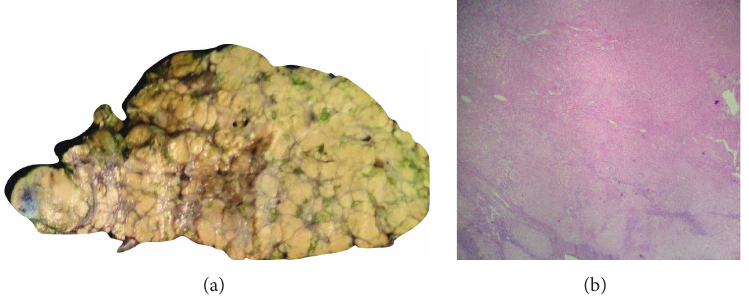
Figure 2: (a) Macroregenerative nodules in explants liver. (b) Photomicrograph showing multiacinar MRN (H&E × 20).